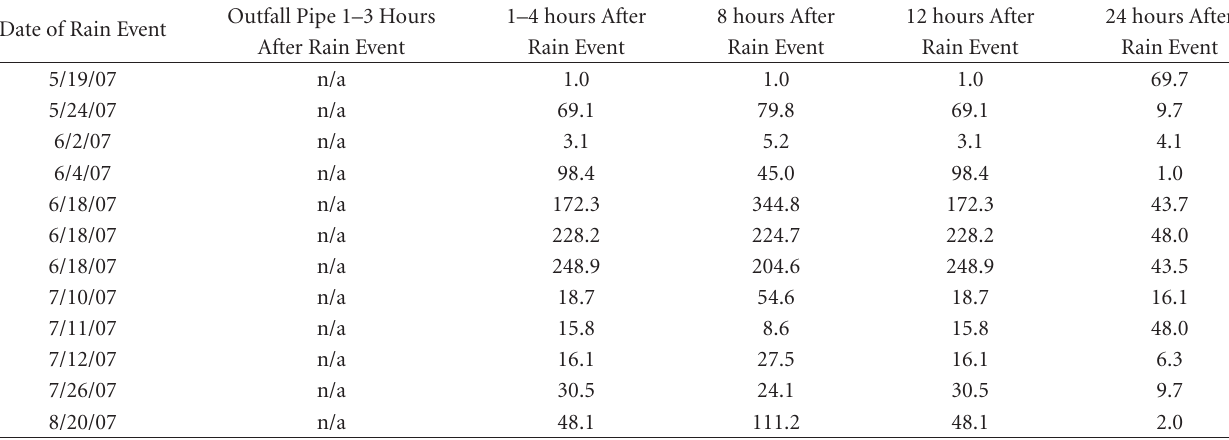
Table 5: E. coli concentrations ( ∗ MPN/100mL) from beach water collected at time intervals following the triggering of a rain event at Murphy Park beach. Using Sche ff e matrix analysis, only E. coli concentrations measured in the first four hours after the rain event was triggered were significantly di ff erent from the seasonal mean E. coli concentration for this beach ( P < . 001). If rainfall was su ffi cient to trigger multiple rain event notifications on one day, then multiple events were sampled.